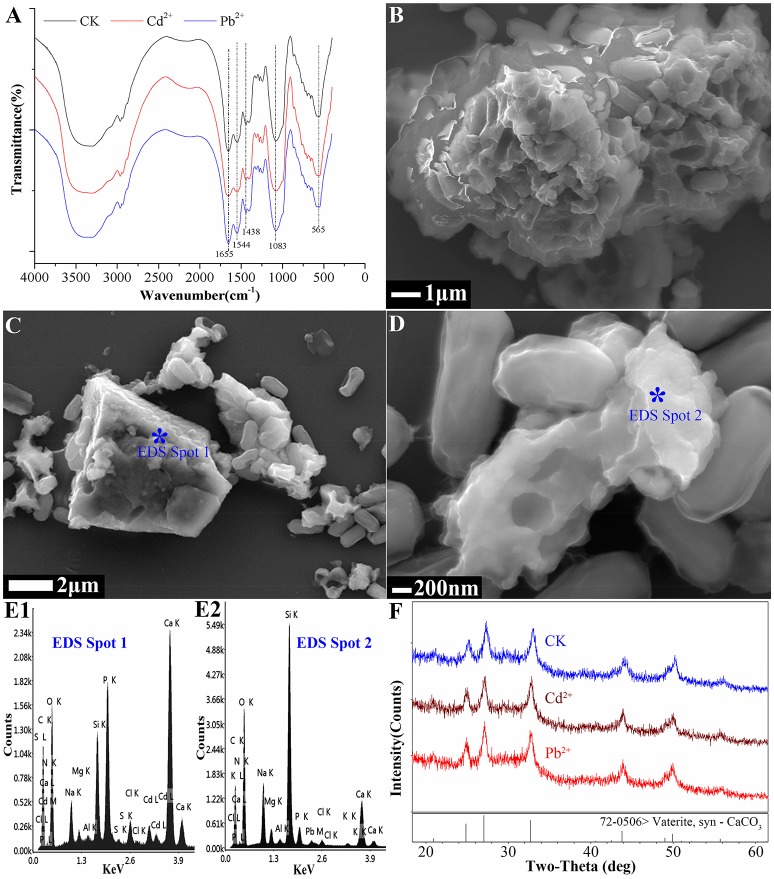
The adsorptive mechanism analysis of Cd2+ and Pb2+ by biogenic CaCO3. (A) The results of FTIR spectra of biogenic CaCO3 before, and after, adsorbing Cd2+ or Pb2+ (CK: before adsorbing Cd2+ or Pb2+ by biogenic CaCO3). (B) The reticular structure of biogenic CaCO3 by FESEM. (C,E1) The result of biogenic CaCO3 after adsorbing Cd2+ (74 mg/L) by FESEM-EDS: Cd2+ is visible on the surface of the biogenic CaCO3. (D,E2) The result of biogenic CaCO3 after adsorbing Pb2+ (94 mg/L) by FESEM-EDS: Pb2+ is visible on the surface of the biogenic CaCO3. (F) The XRD results of biogenic vaterite before, and after, adsorbing Cd2+ and Pb2+ (CK: before adsorbing Cd2+ and Pb2+ by biogenic CaCO3). The “*” inside the figure is the site of the EDS spot.